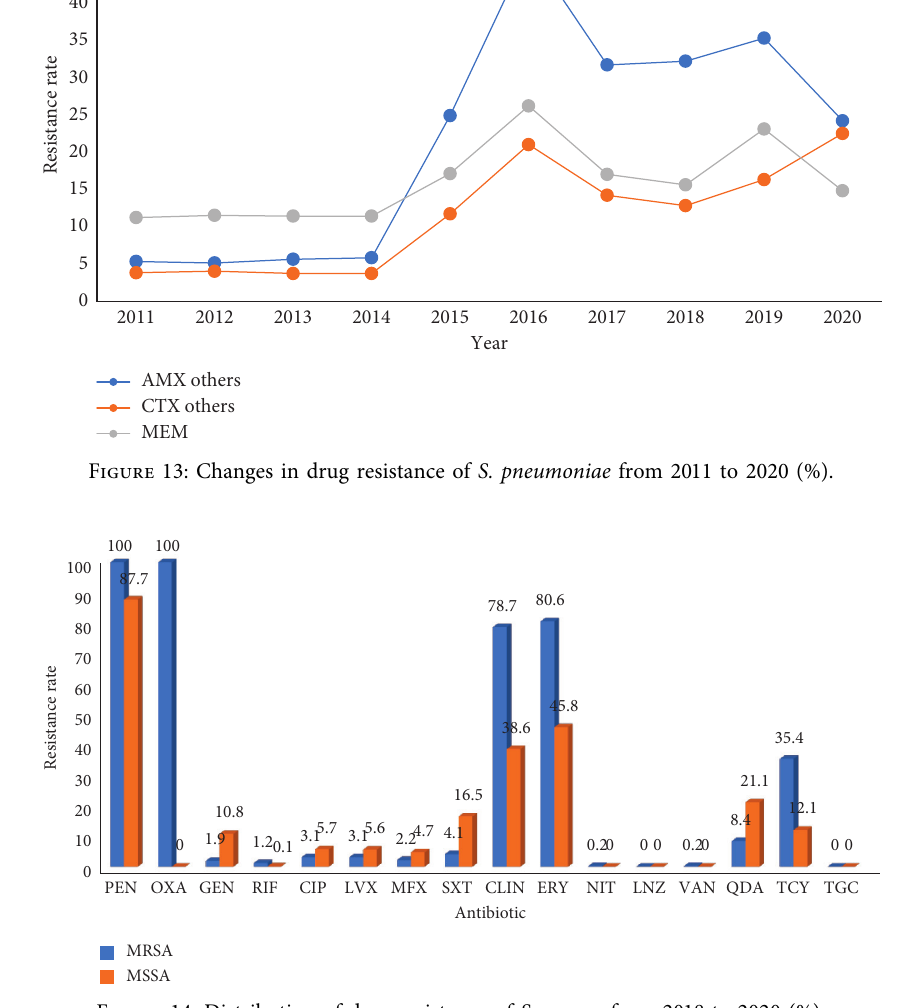
Figure 14: Distribution of drug resistance of S. aureus from 2018 to 2020